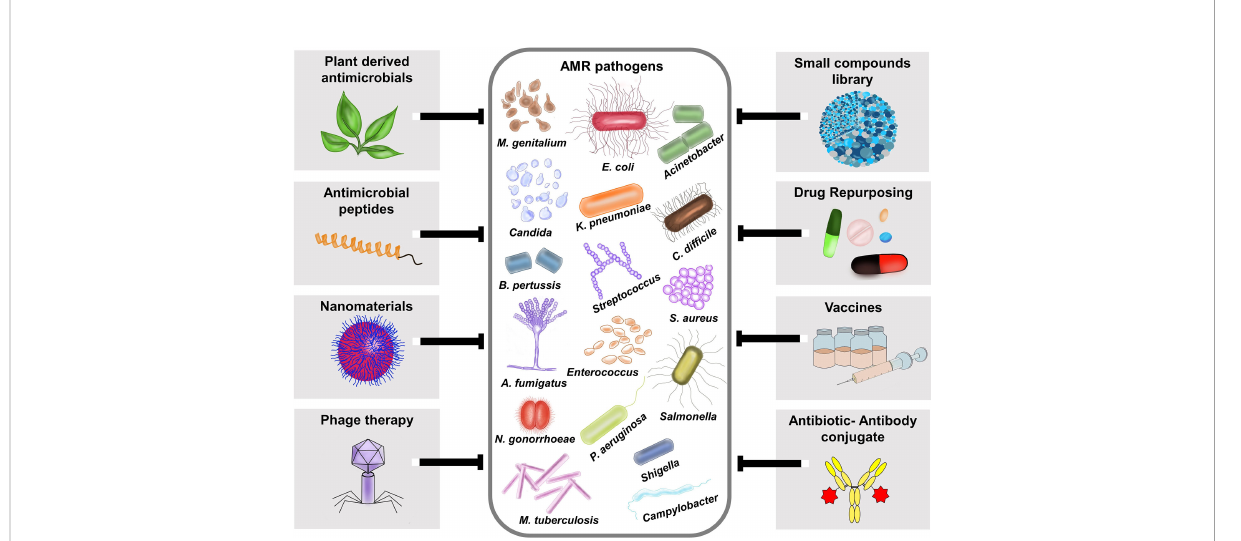
FIGURE 1 Different therapeutic strategies for combating antimicrobial resistant pathogens. AMR pathogens depicted in the fi gure is based on the Centers for Disease Control and Prevention (CDC), 2019 antibiotic resistance threats report, which categorized the AMR pathogens into urgent threats, serious threats, concerning threats and watch list https://www.cdc.gov/drugresistance/biggest-threats.html. Various therapeutic approaches like plant- derived antimicrobials, antimicrobial peptides (AMPs), Nanomaterials, Phage therapy, small compound library screening, Drug repurposing, Vaccines, and Antibiotic-Antibody conjugates (AAC) are currently available to fi ght against AMR